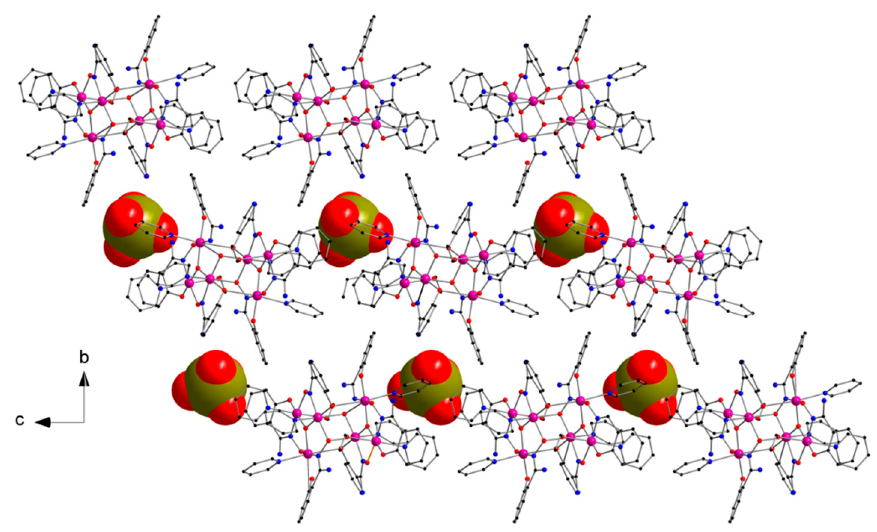
Figure 4. View along the crystallographic a axis of a fragment of the packing of 2 showing the arrangement of the [Mn 6 ] 2+ cations and [ReO 4 ] − anions (space-filling model). H atoms have been omitted for clarity. Color code: Pink, Mn; red, O; blue, N; black, C; green, Re.